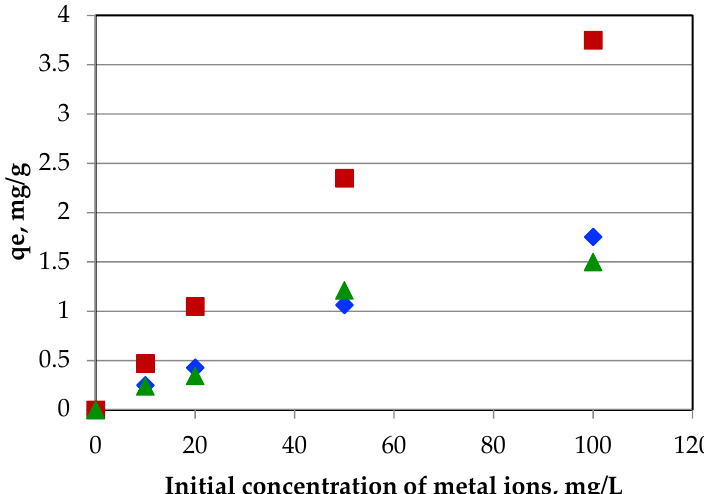
11 of 18 Figure 8. Photographs of the GS 2:1 hybrids after adsorption of metal ions: ( a ) copper(II), ( b ) lead(II), ( c ) cadmium(II). 3.6.2. pH Changes during Metal Adsorption pH is an important factor affecting the performance of the metal ion sorption process, which can affect both the form of the metal ion in the solution and the surface properties of the sorbent. The latter is dependent on the competition between metal ions and protons in available binding sites or results from ion exchange. We examined the influence of con- tact time on the pH of solutions during adsorption. The results are presented in Figure 9. Typically, during the adsorption process of metal ions the concentration of hydrogen ions increases however, in our studies, we observed that the solution became more basic. Such behavior is due the sodium carbonate used for the synthesis of hybrid monoliths. During the experiment sodium carbonate was leached from the hybrids and changed pH. There- fore, the initial pH value was controlled and adjusted during the metal adsorption pro- cess. In order to avoid the precipitation of metal hydroxides, which can occur when the pH of the solution is too high, 0.1 M of HNO 3 was added to the metal solutions before